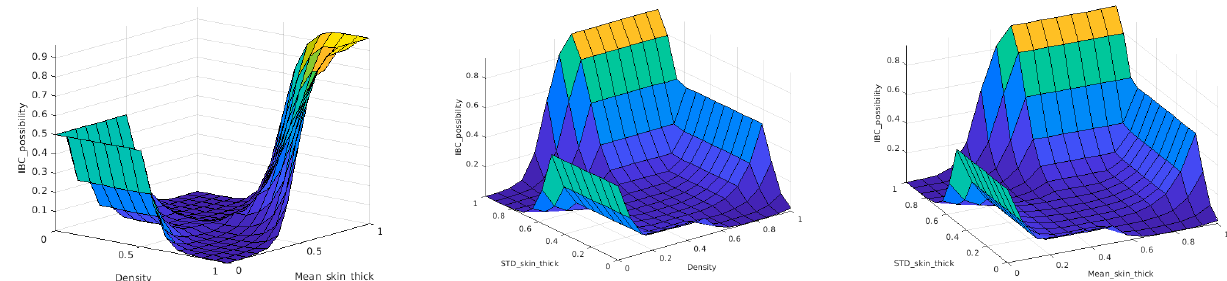
Figure 9. Decision surface of the proposed Type-1 fuzzy classifier. Table 2. Fuzzy rules in the proposed Type-1 and Type-2 classifiers.